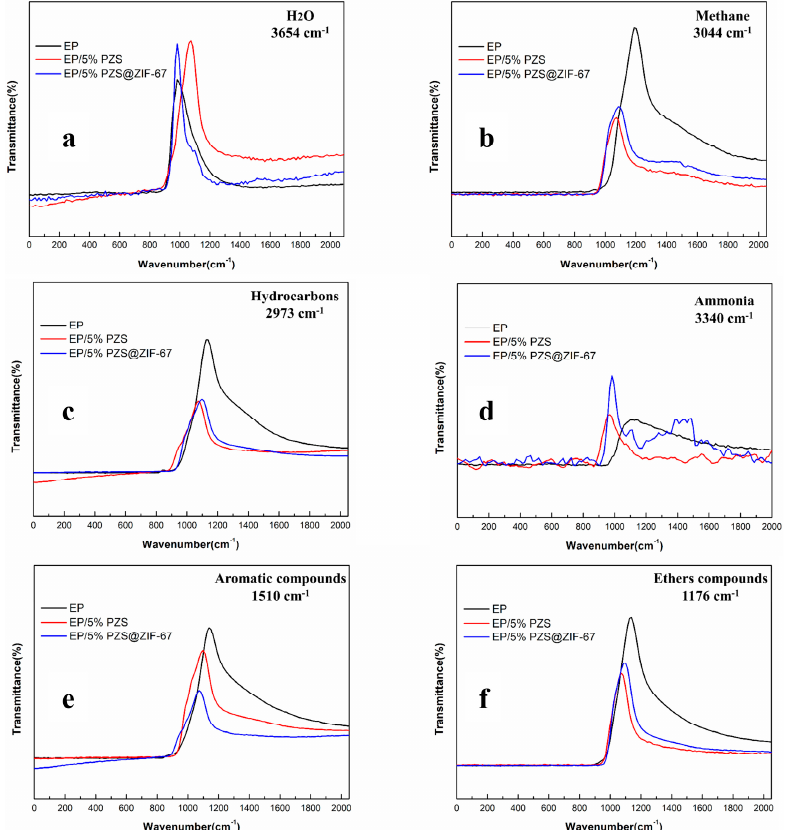
Figure 12. FTIR spectra of pyrolysis products of EP, EP/5% PZS, and EP/5% PZS@ZIF-67 vs. time: ( a ) H 2 O; ( b ) methane; ( c ) hydrocarbons; ( d ) ammonia; ( e ) aromatic compounds; and ( f ) ether com- pounds.